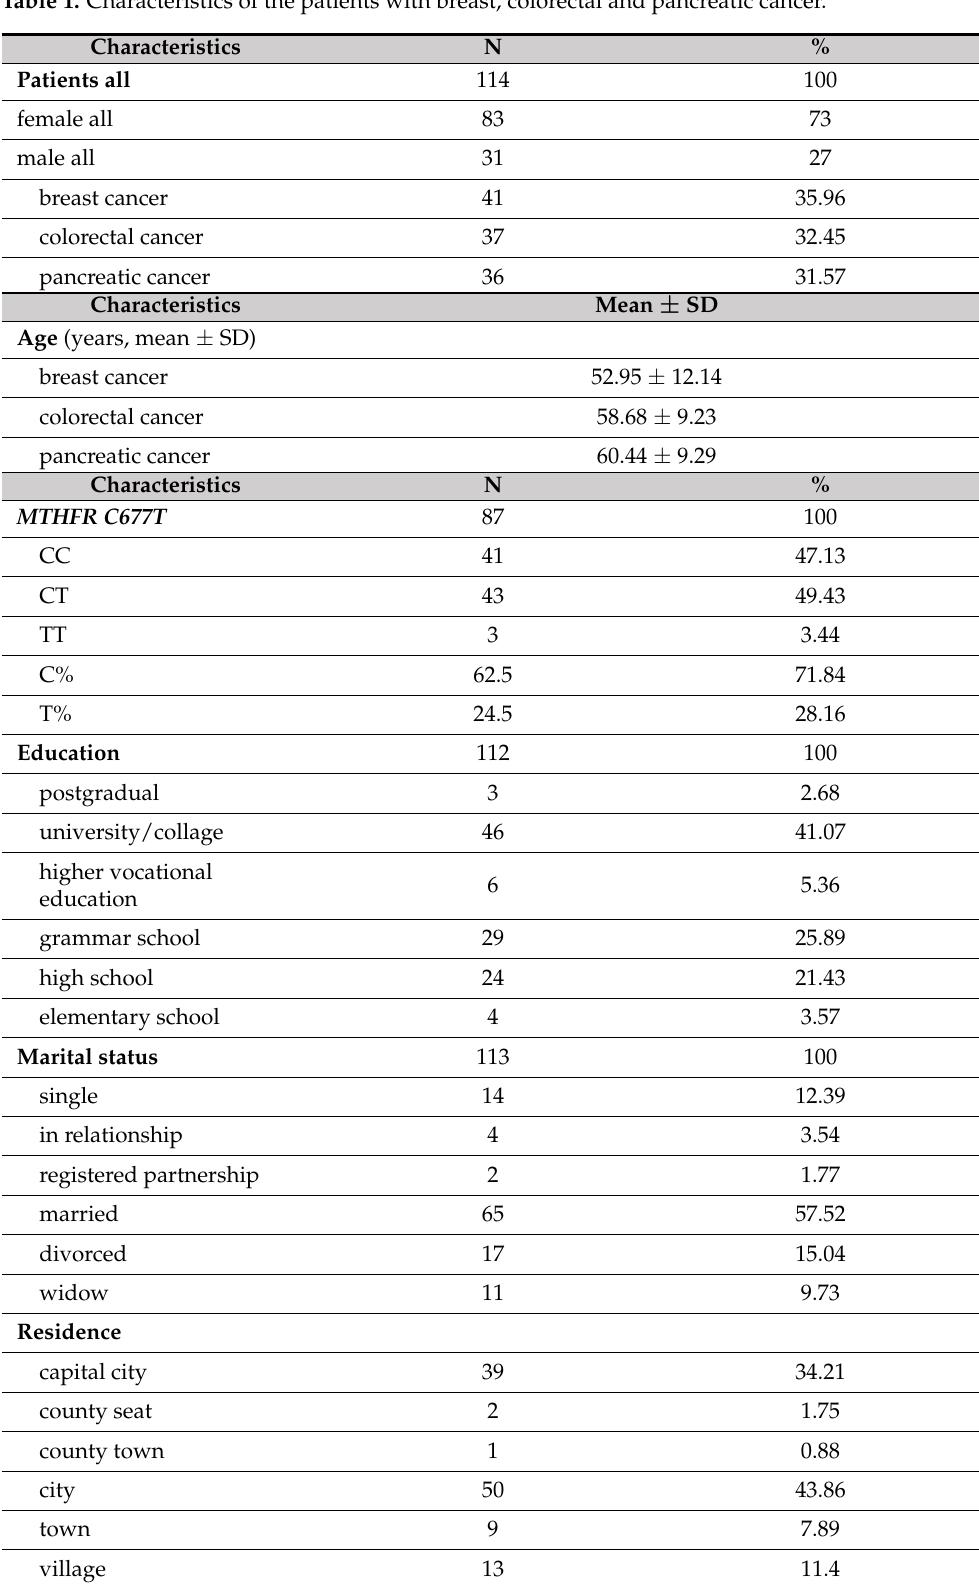
Table 1. Characteristics of the patients with breast, colorectal and pancreatic